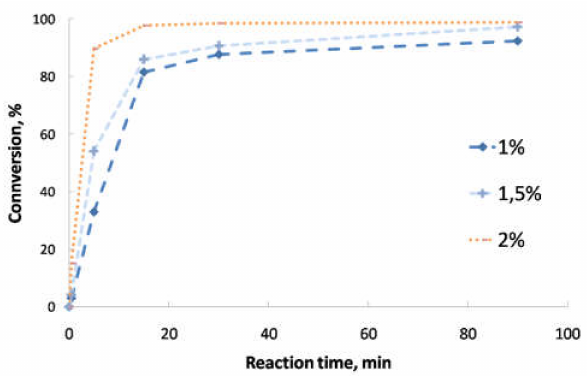
Figure 4. Effect of catalyst concentration (FAME:alcohol ratio, 1:1; reaction temperature, 100 ◦ C; stirring rate, 500 rpm; reaction time, 90 min).